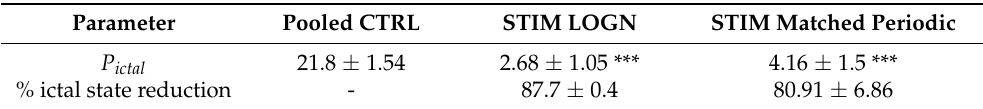
Table 3. Effect of lognormal and matched periodic stimulation on ictal activity (dataset summarized in Figure 5). *** p < 0.0001.